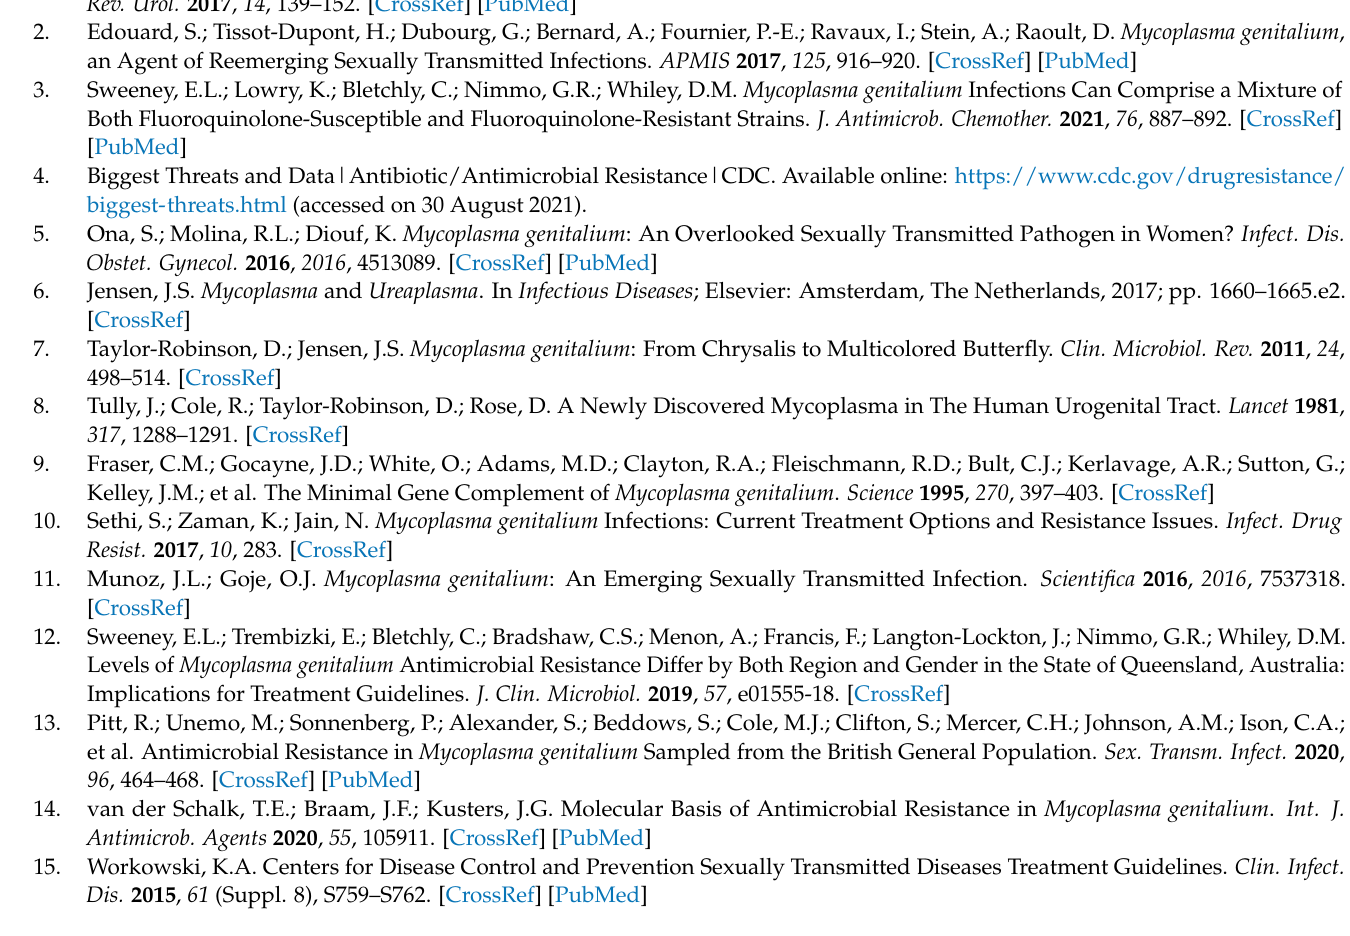
Figure S2: Overall quality factor as projected by ERRAT; Figure S3: 3D model of vaccine construct as generated by Robetta, Table S1: Selected Mycoplasma genitalium proteins; Table S2: CTL(9-mer) and HTLs selection, Table S3: Galaxy refine structure data. Supplementary file